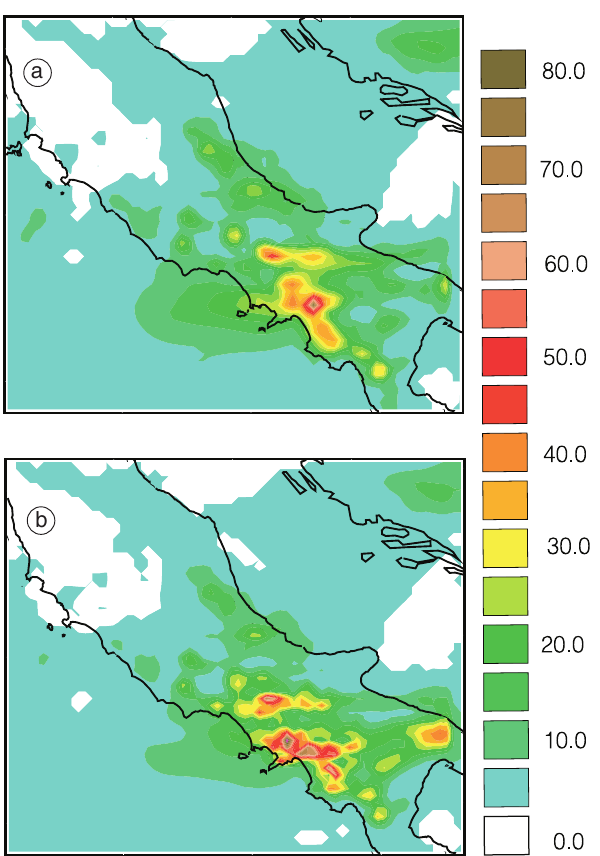
Fig. 5a,b. As for fi g. 4a,b but on domain 2 using a two way nesting: a) between domain 1 and 2 at the same resolution of fi g. 4b; b) between domain 2 and 3 at 9 and 3 km resolution, respectively.